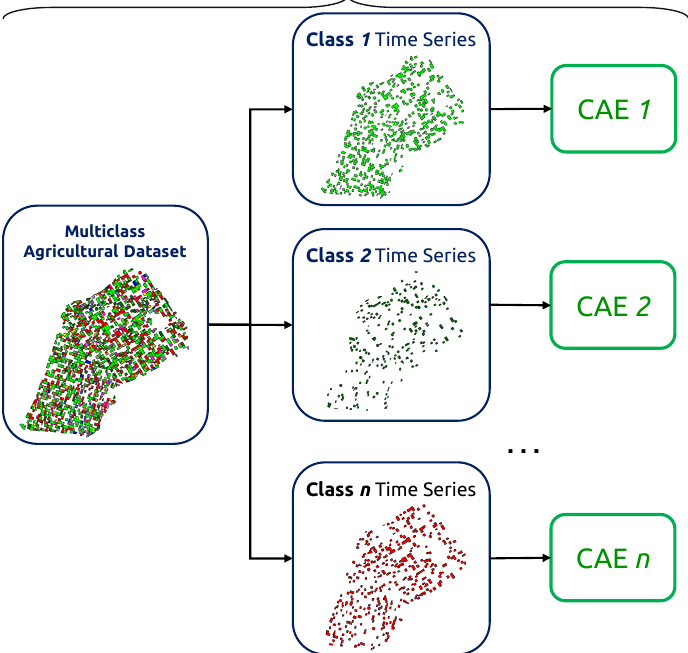
Figure 7. Class-expert CAEs parallel training.